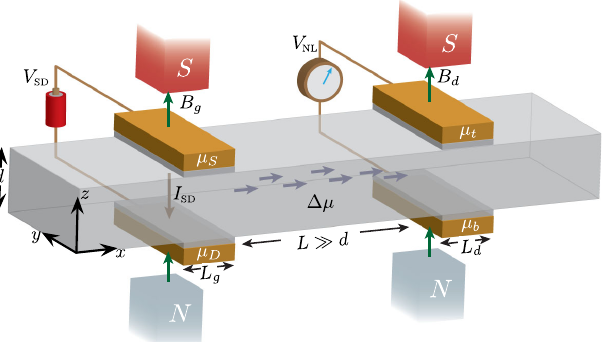
FIG. 1. Nonlocal transport experiment. A source-drain current I is injected into a Weyl semimetal slab of thickness d via SD tunneling contacts of thickness L . In the presence of a local g generation magnetic field B , a valley imbalance Δ μ is created via g the chiral anomaly and diffuses a distance L ≫ d away. If a detection field B is applied, the valley imbalance can be d converted into a potential difference V between top and bottom NL contacts of size L d